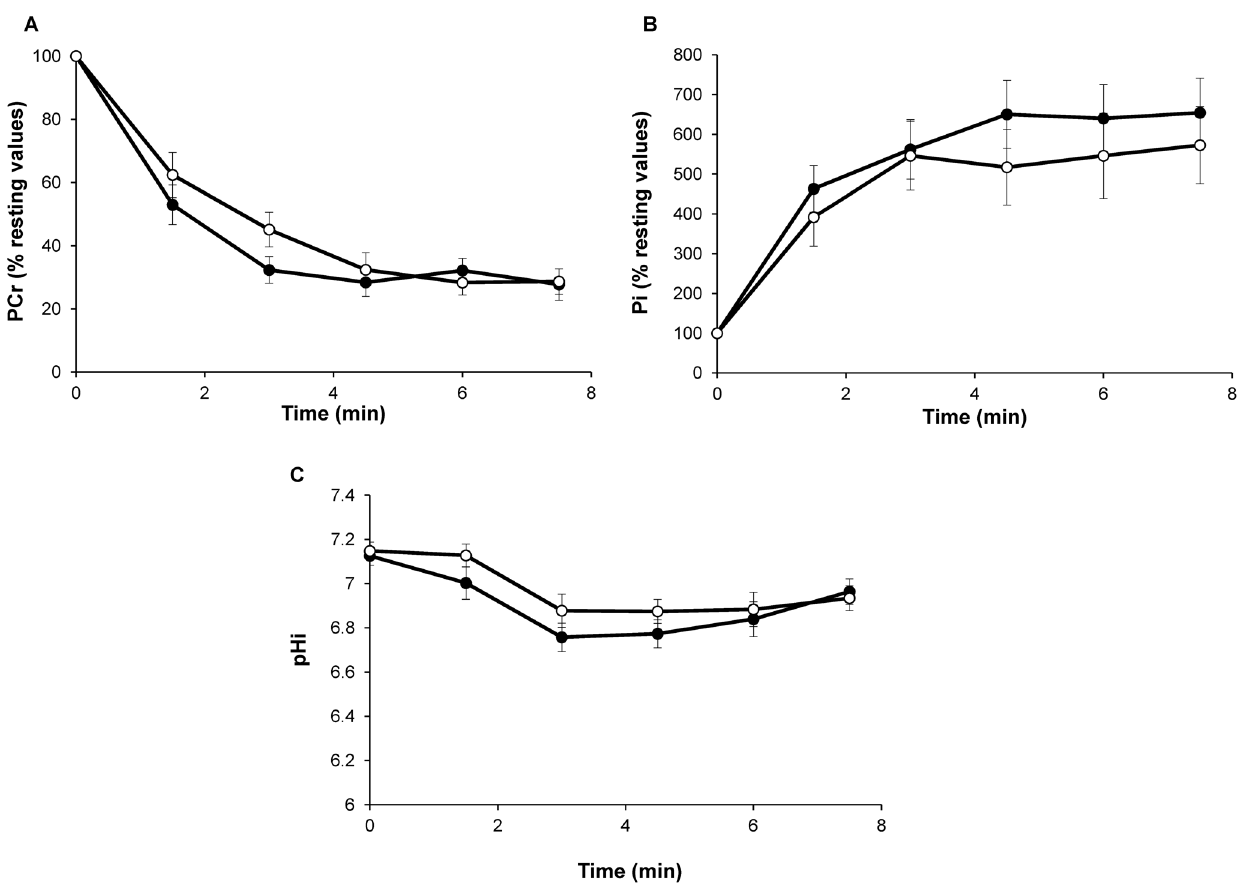
Figure 5. Changes in gastrocnemius PCr (% resting value; A), Pi (% resting value; B), and pHi (C) during the stimulation protocol were similar in H40Y ( # ) and WT ( N ) groups. Values are presented as mean 6 SEM.